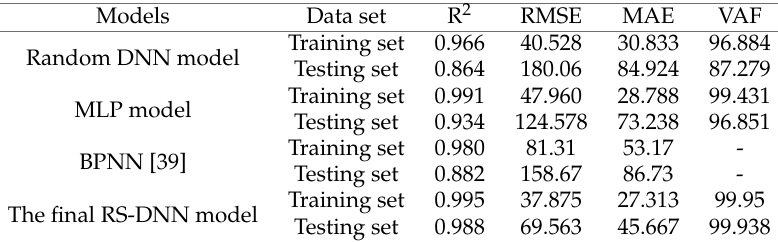
Table 9. Comparison with other machine learning models